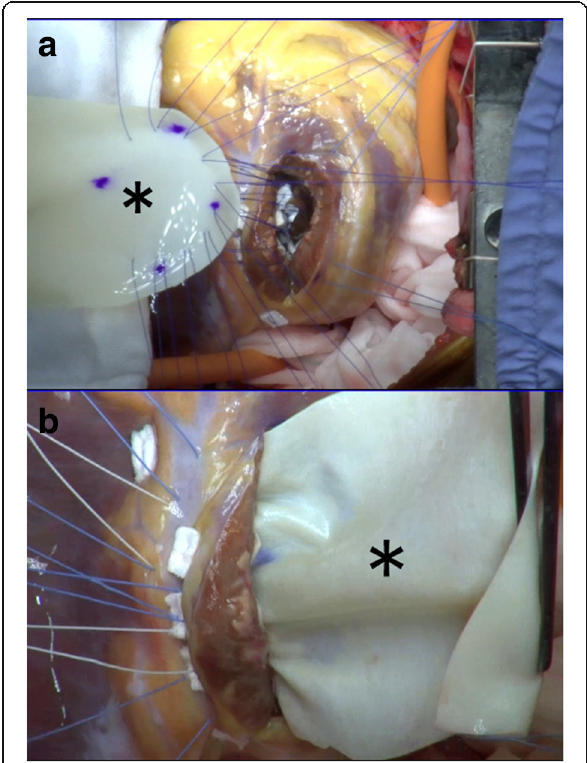
Fig. 3 Steps of secondary closure of the septal defect. a A primary patch is undergoing additional covering of the comet-shaped secondary patch (asterisk). b The endoventricular polypropylene sutures ( ② in Fig. 1b) were succeeded by 2/0 braided sutures brought out to the interventricular groove ( ③ in Fig. 1b). This row was not only to complete the secondary closure of the septal defect but also to hold the external patch. It forms a hinge line between two parts of the secondary patch. The back side of the